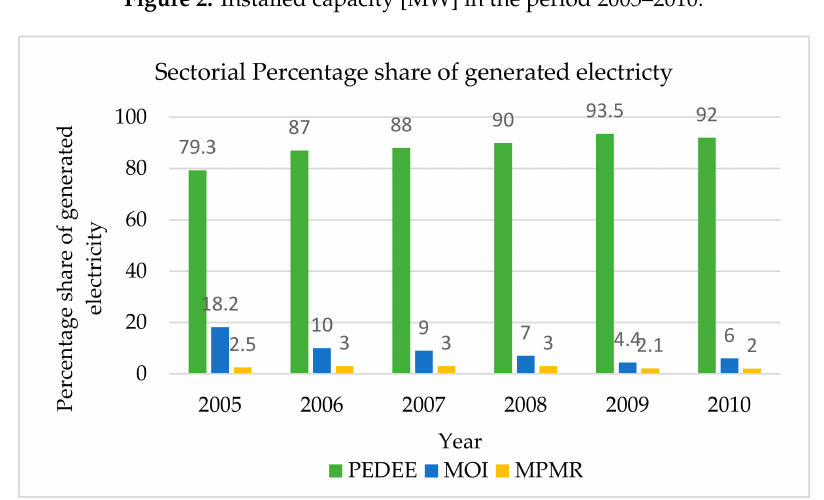
Figure 3. Sectorial percentage share of generated electricity in the period (2005–2010).